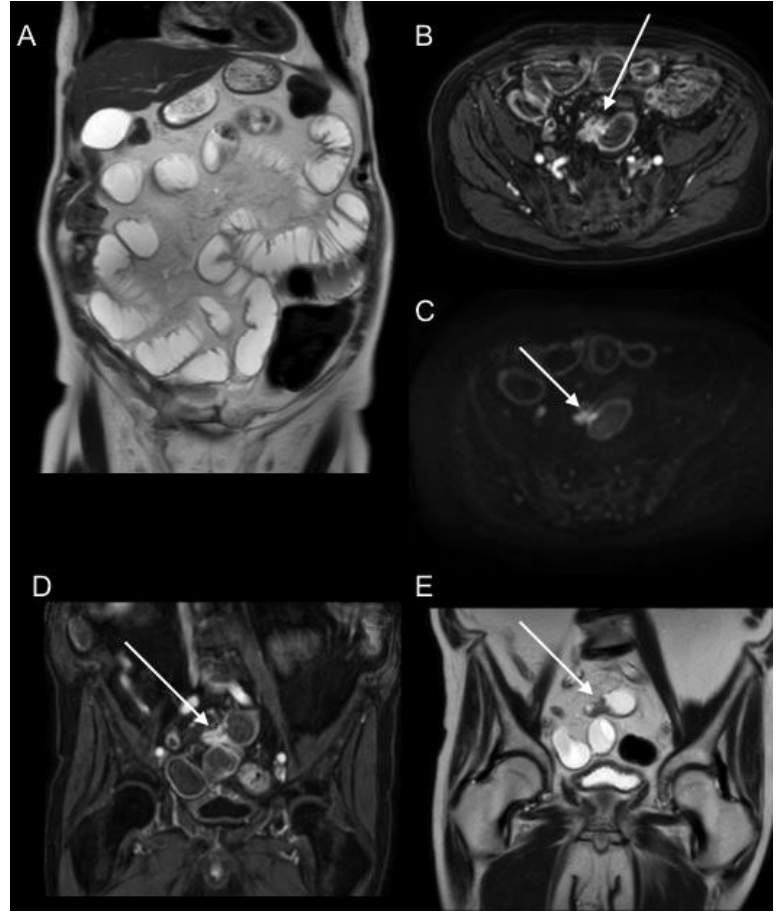
Figure 11. T2WI coronal and axial ( A , E ), postGD DIXON axial and coronal ( B , D ), and DWI b1000 axial ( C ) MR images show an intestinal obstruction due to ileal serosal implant (arrows).